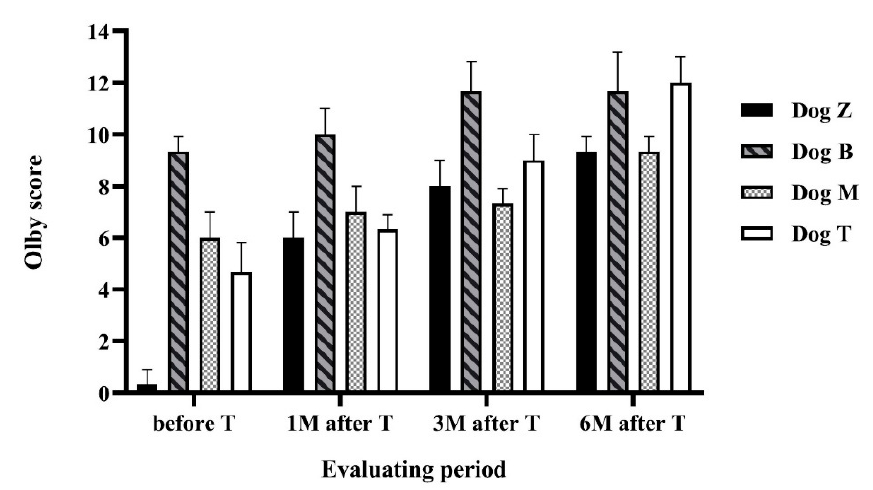
Figure 3. Locomotor function evaluated using Olby scale. The figure shows the Olby scores assessed in every dog during the study period. Values were obtained before therapy, then one, three and six months after therapy in each dog. Each measurement represents mean value of three